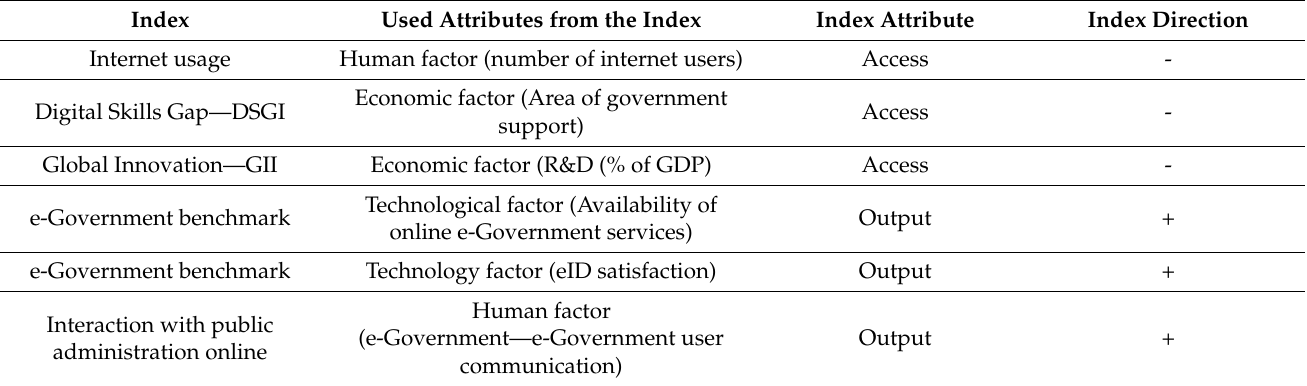
Table 8. Input and output DMU